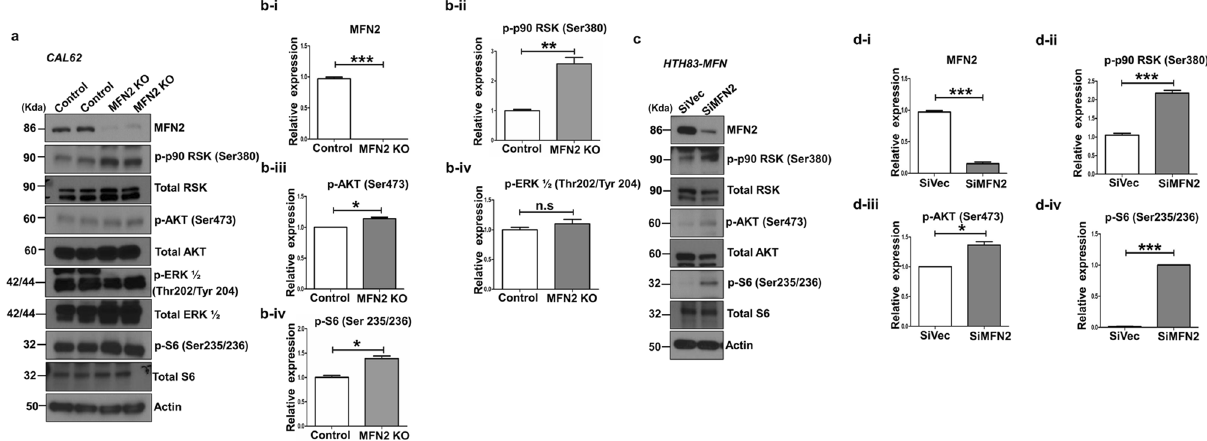
Figure 4. Mitofusin-2 is a negative regulator of the PI3K/AKT signaling pathway. ( a ) Immunoblotting of Mitofusin-2, p-p 90 RSK (Ser380), p AKT (Ser473), p ERK1/2 (Thr202/Tyr204), and p- S6 (Ser 235/236) was conducted using cell lysates from MFN2 KO and control Cal62 cells. ( b ) Quantification of immunoblotting for ( b-i ) MFN2, (B-ii) p-p 90 RSK (Ser380), ( b-iii ) p-AKT (Ser473), ( b-iv ) p ERK1/2 (Thr202/Tyr204), and ( b-v ) p- S6 (Ser 235/236) after MFN2 KO in Cal62 cells. ( c ) Immunoblotting for investigating the levels of MFN2, p-p 90 RSK (Ser380), p AKT (Ser473), and p- S6 (Ser235/236) was performed using cell lysates from SiMFN2 HTH83 and control SiVector HTH83 cells. ( d ) Quantification of the levels of ( d-i ) MFN2 , ( d-ii ) p-p 90 RSK (Ser380), ( d-iii ), p-AKT (Ser473), and ( d-iv ) p- S6 (Ser 235/236) after transfection with SiMFN2 in HTH83 cells.